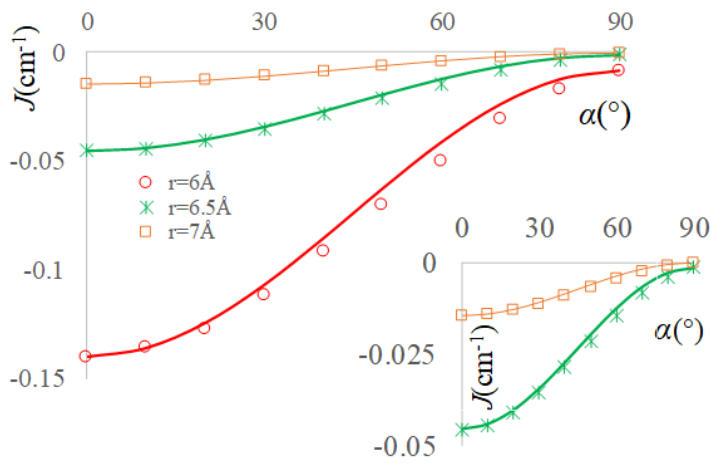
Figure 6. The exchange integrals as function of the α angle for ‘b’-type the TEMPO ... CH 2 Cl 2 ... TEMPO complexes. The content is similar to the representation from Figure 5.